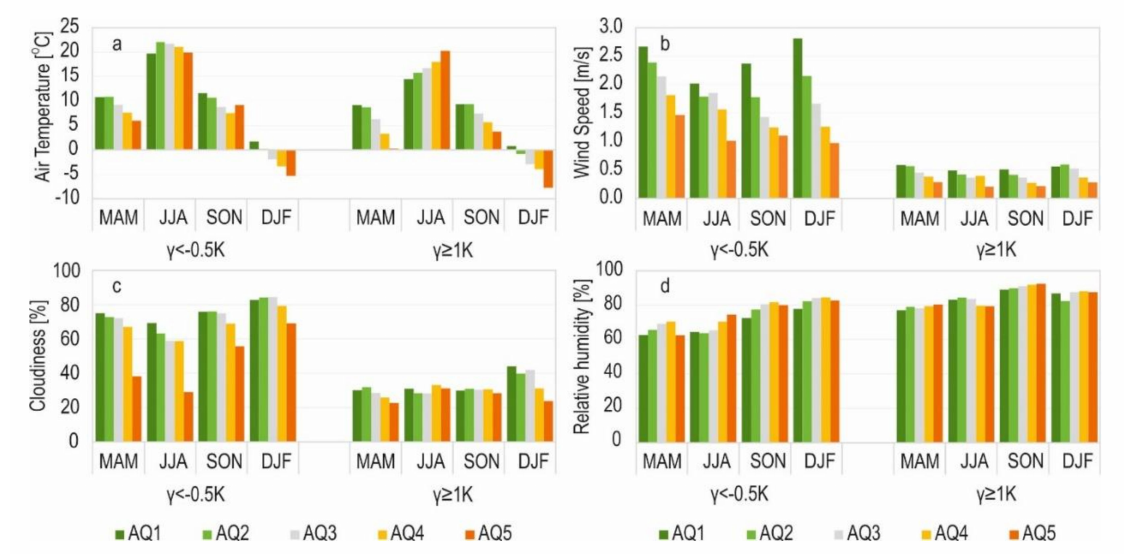
Figure 10. Average air temperature ( a ), wind speed ( b ), cloudiness ( c ) and relative humidity ( d ) for strong and conditionally unstable ( γ < − 0.5 K) and stable ( γ ≥ 1.0 K) atmospheres depending on air quality classes in Sosnowiec.